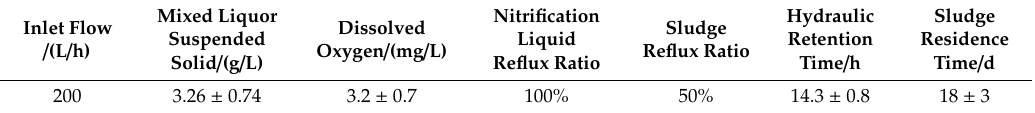
Table 3. The improved anaerobic–anoxic–aerobic-ozone (A 2 / O) operating conditions.